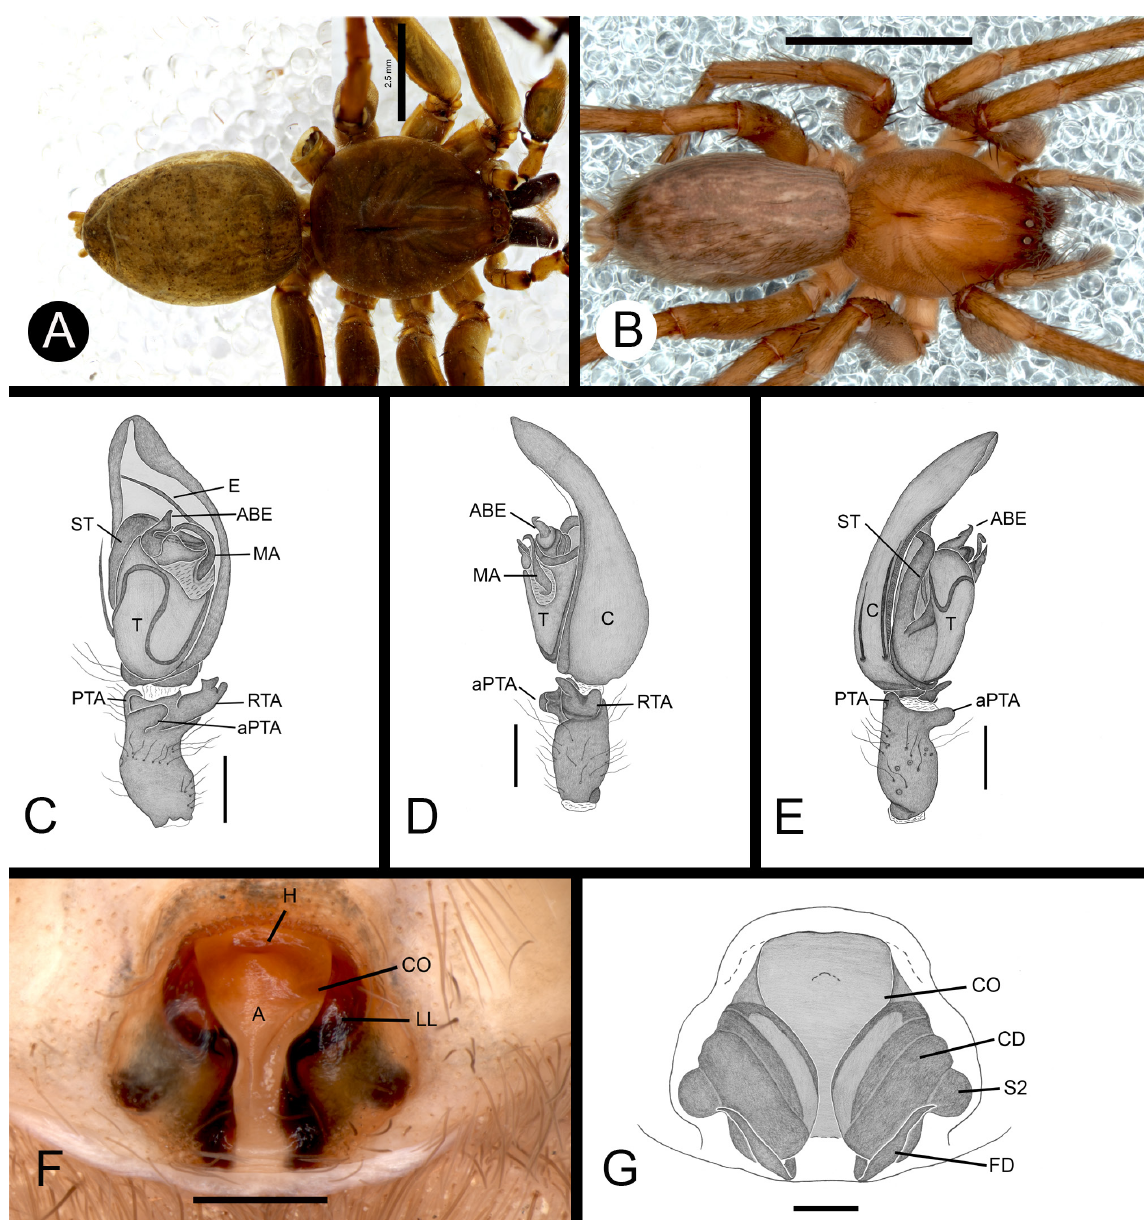
Fig. 13. Tafana quelchi (Pocock, 1895) (A, C–E= ♂, BMNH 1895.3.30.1; B ♀, IBSP 32131; F–G = ♀, IBSP 32131). A . Habitus, dorsal view. B . Habitus, dorsal view. C . Left palp, ventral view. D . Left palp, retrolateral view. E . Left palp, prolateral view. F . Epigynum, ventral view. G . Vulva, dorsal view. Abbreviations: A = atrium; ABE = apophysis of base of the embolus; aPTA = apical prolateral tibial apophysis; C = cymbium; CD = copulatory ducts; CO = copulatory opening; E = embolus; FD = fertilization ducts; H = hood; LL = lateral lobes; MA = median apophysis; PTA = prolateral tibial apophysis; RTA = retrolateral tibial apophysis; ST = subtegulum; S2 = secondary spermathecae; T = tegulum. Scale bars: A–B = 3.5 mm; C–G = 0.25